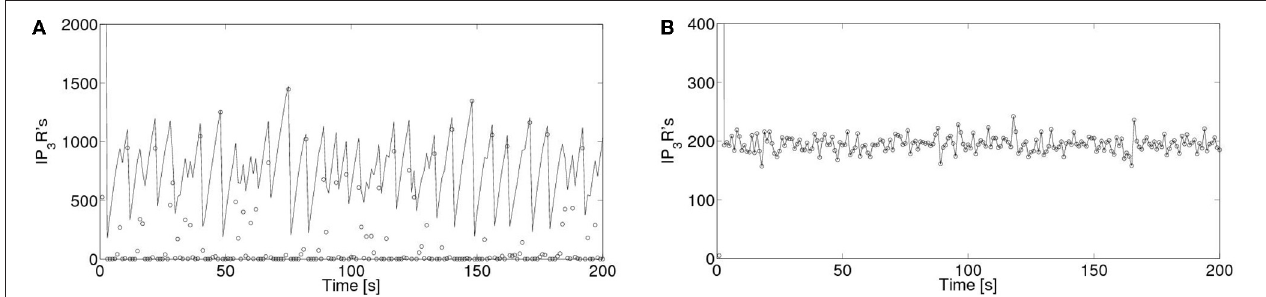
FIGURE 10 | Number of active IP 3 R’s and of IP 3 R’s that are participating of a signal as a function of time. Number of active IP 3 R’s, N act (with solid lines) and of open IP 3 R’s, N o (with open circles) as a function of time for (A) δ Ca = 200 / s and for (B) δ Ca = 20 /